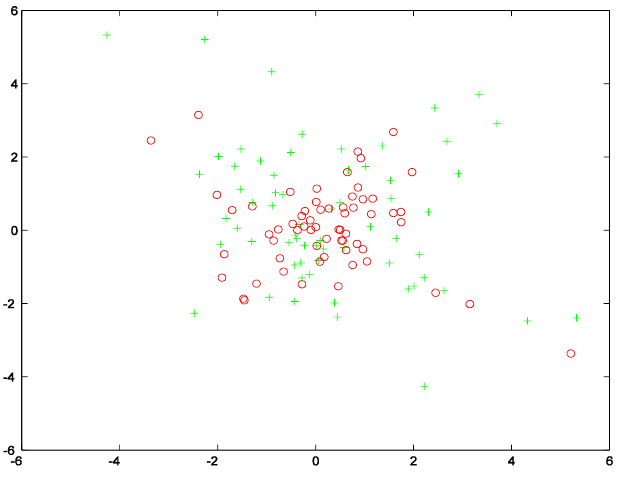
Figure 6. 𝑤 𝑡(128) as a function of 𝑤 𝑡−1(128) (plusses: high scatter, when g t = 2; circles: small scatter, when g t = 0.5).